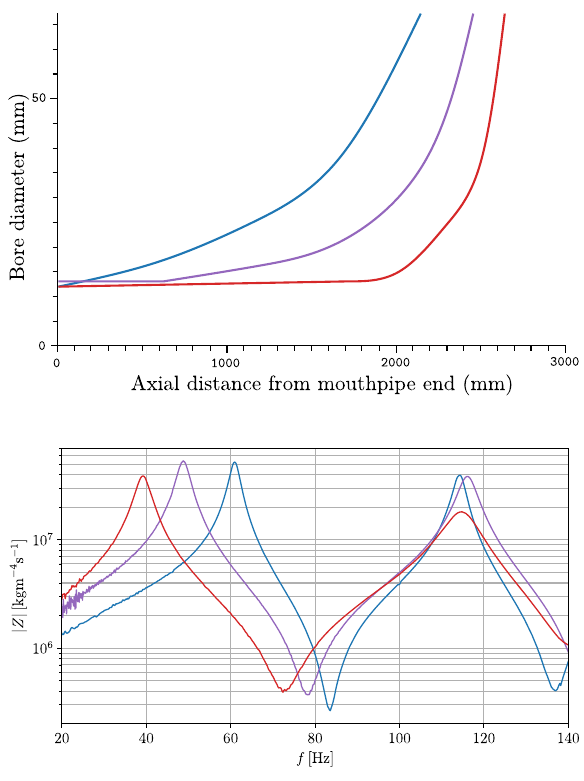
Figure 8. Top: bore pro fi le as a function of the axial distance to mouthpipe end, taken from [1] (where bore pro fi les of several other instruments can be found); bottom: modulus of the input impedance as a function of frequency (zoom on the fi rst two peaks). Red: bass trombone; purple: B [ -baritone saxhorn; blue: B [ -euphonium. Figure 9. Natural notes playable by a B [ -baritone saxhorn, that is to say without depressing any valves. From left to right: B [ 1 (pedal note), C2 (ghost note, naturally a bit fl at compared to an equal tempered scale), B [ 2, F3, B [ 3, D4, F4, A [ 4 (naturally a bit fl at compared to an equal tempered scale), B [